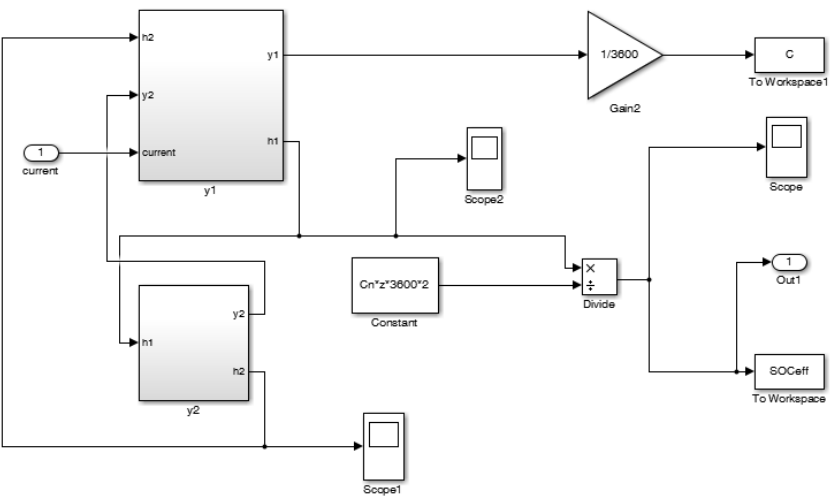
Figure 10. The schematic of the state of charge (SOC) estimator in Simulink environment: the sub-blocks 𝑦 1 and 𝑦 2 estimate the available charge and bound charges, respectively.